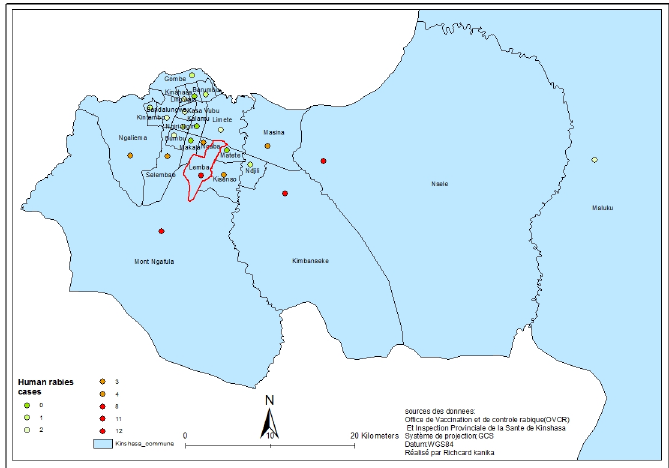
Fig 1. The spatial distribution of human clinical cases of rabies in Kinshasa from 2003to